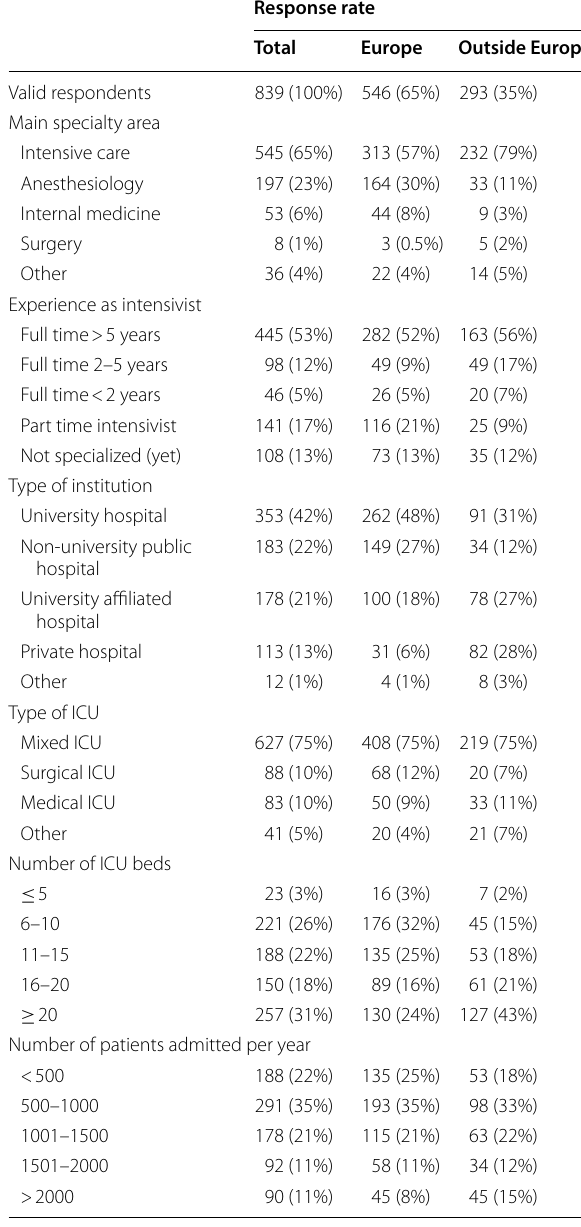
Table 1 Baseline characteristics of survey